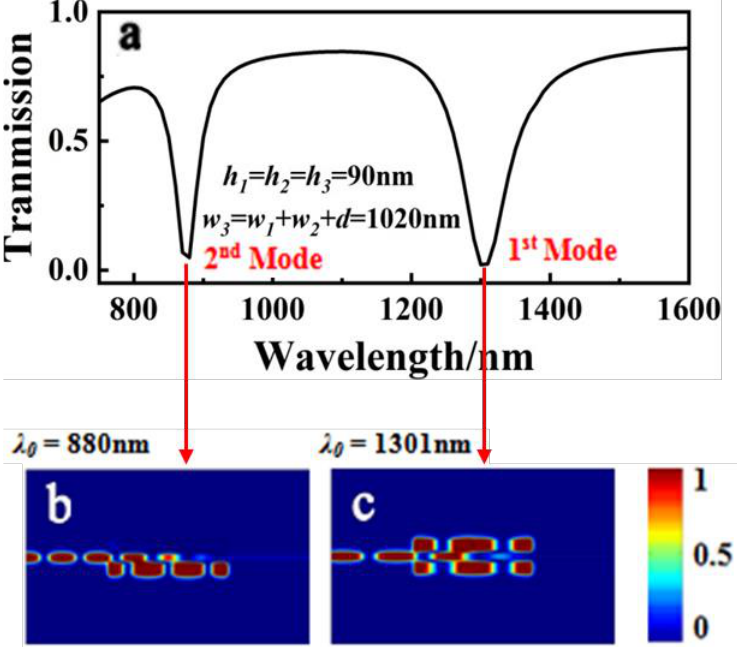
Figure 3. ( a ) Transmission spectrum of the MIM waveguide with the three-rectangle resonators shown in Figure 1 when h 1 = h 2 = h 3 = 90 nm and w 3 = w 1 + w 2 + d = 1020 nm. The field distribution |H z | 2 of the structure at an incident wavelength of ( b ) 880 nm and ( c ) 1301